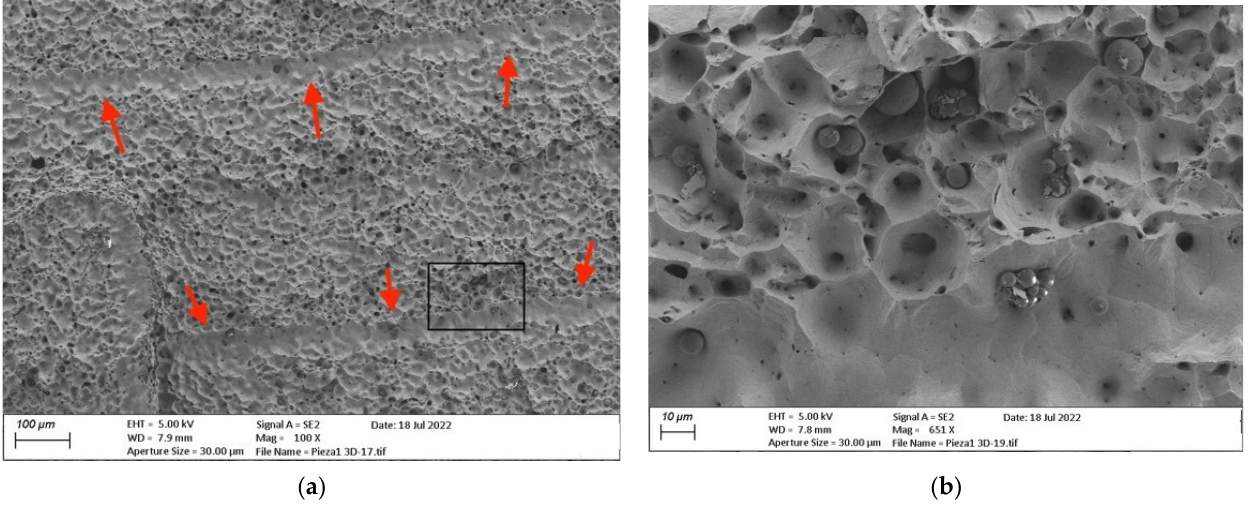
Figure 15. FESEM images of fractured ADAM copper cubic sample: ( a ) Fractured area (100× ampli- fication factor) with voids and clearly marked regions between filaments (marked with arrows); ( b ) Detail (651×) where the inter-filament regions are clearly larger (larger voids) and not fractured, while the constriction effect during the fracture is clearly observed in the edges around the small holes (upper part of the image).